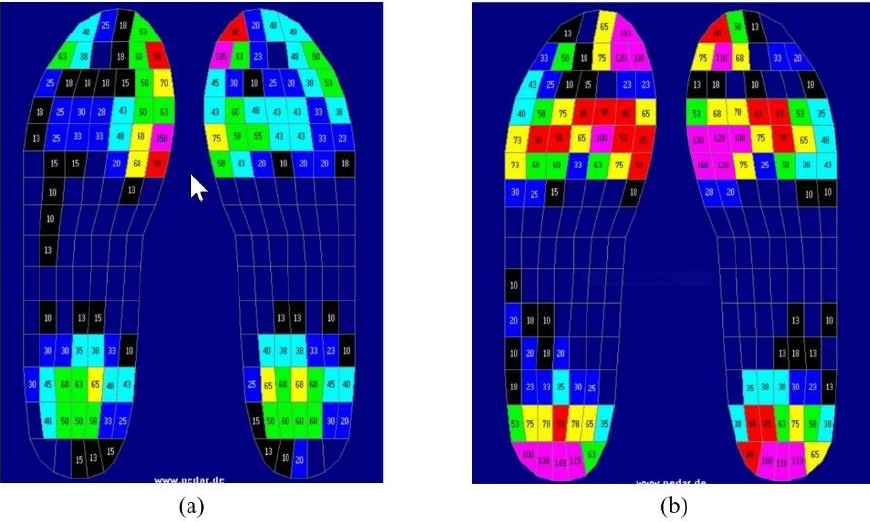
Figure 6. Examples of the plantar pressure distribution per region: ( a ) Wearing the insoles; and ( b ) not wearing the insoles.